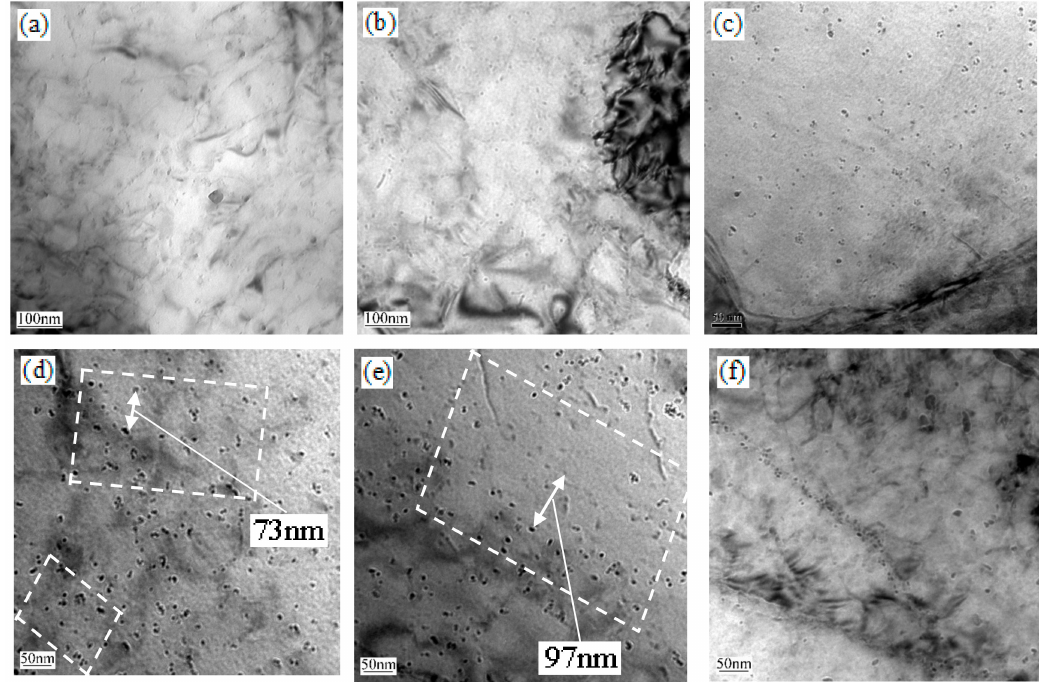
Figure 9. The precipitate particles of the specimens after isothermally held at ( a ) 550 ◦ C; ( b ) 600 ◦ C; ( c ) 650 ◦ C; ( d ) 700 ◦ C; ( e ) 750 ◦ C; ( f ) 800 ◦ C There were a few large-sized precipitates besides fine dispersed precipitates at 550 ◦ ◦ 700 C, and 800 C holding temperatures in Figure 10 in bright filed. They exhibited square-shaped morphology, and the precipitate particle dimensions were ~68 × 105 and ~53 × 94 nm 2 (Figure 10a,c). Spherical precipitates were of diameters ~49 and ~52 nm (Figure 10e,g)). These precipitates were undissolved (Nb, Ti) (C, N) particles which could be confirmed by EDS analysis (Figure 10b,d,f,h).